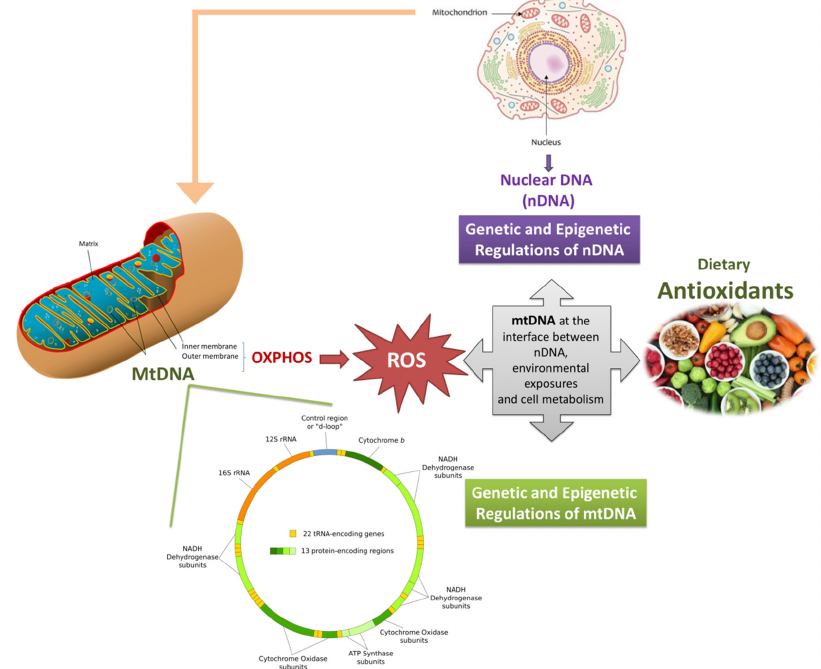
Figure 1. Graphical representation of the interplay between mitochondrial genome (and epigenome), dietary antioxidants, and mitochondrial health. Mitochondria produces energy but also ROS, whose overproduction might induce mitochondrial dysfunctions, also through the alteration of the mitochondrial genome. Dietary antioxidants, can promote the mitochondrial function by reducing ROS production, modulating epigenetic pathways and, thus, restoring cellular homeostasis. Since mitochondrial dysfunctions (in particular those triggered by ROS) are typical of neurodegeneration, the role of dietary antioxidants in preventing these multifactorial diseases can be central, and it might pass through the protection of genetic and epigenetic features of the mitochondrial